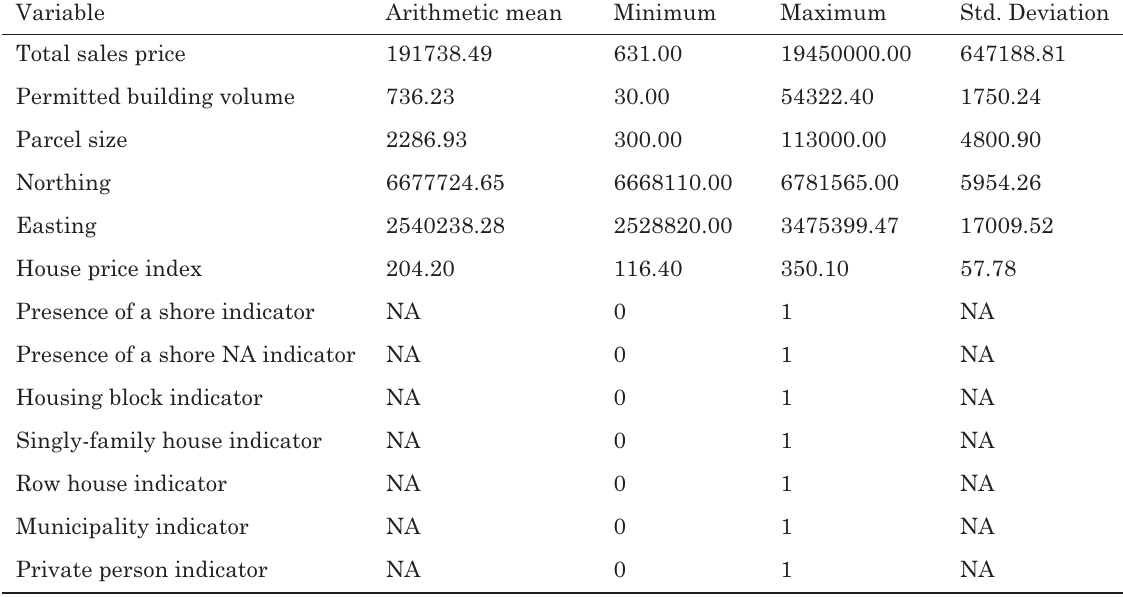
Table 1. Sample statistics of study variables